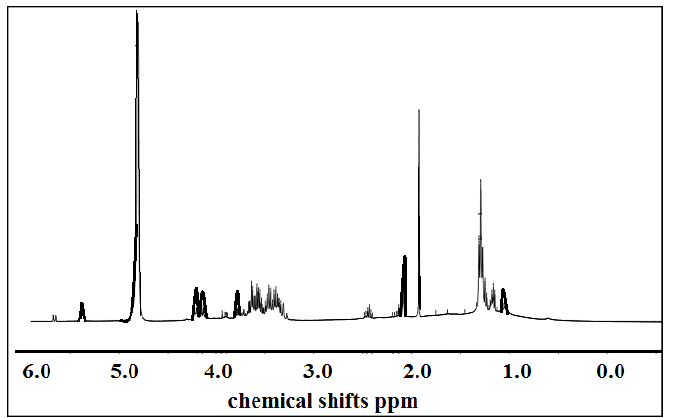
Figure 2. 1 H NMR spectrum of